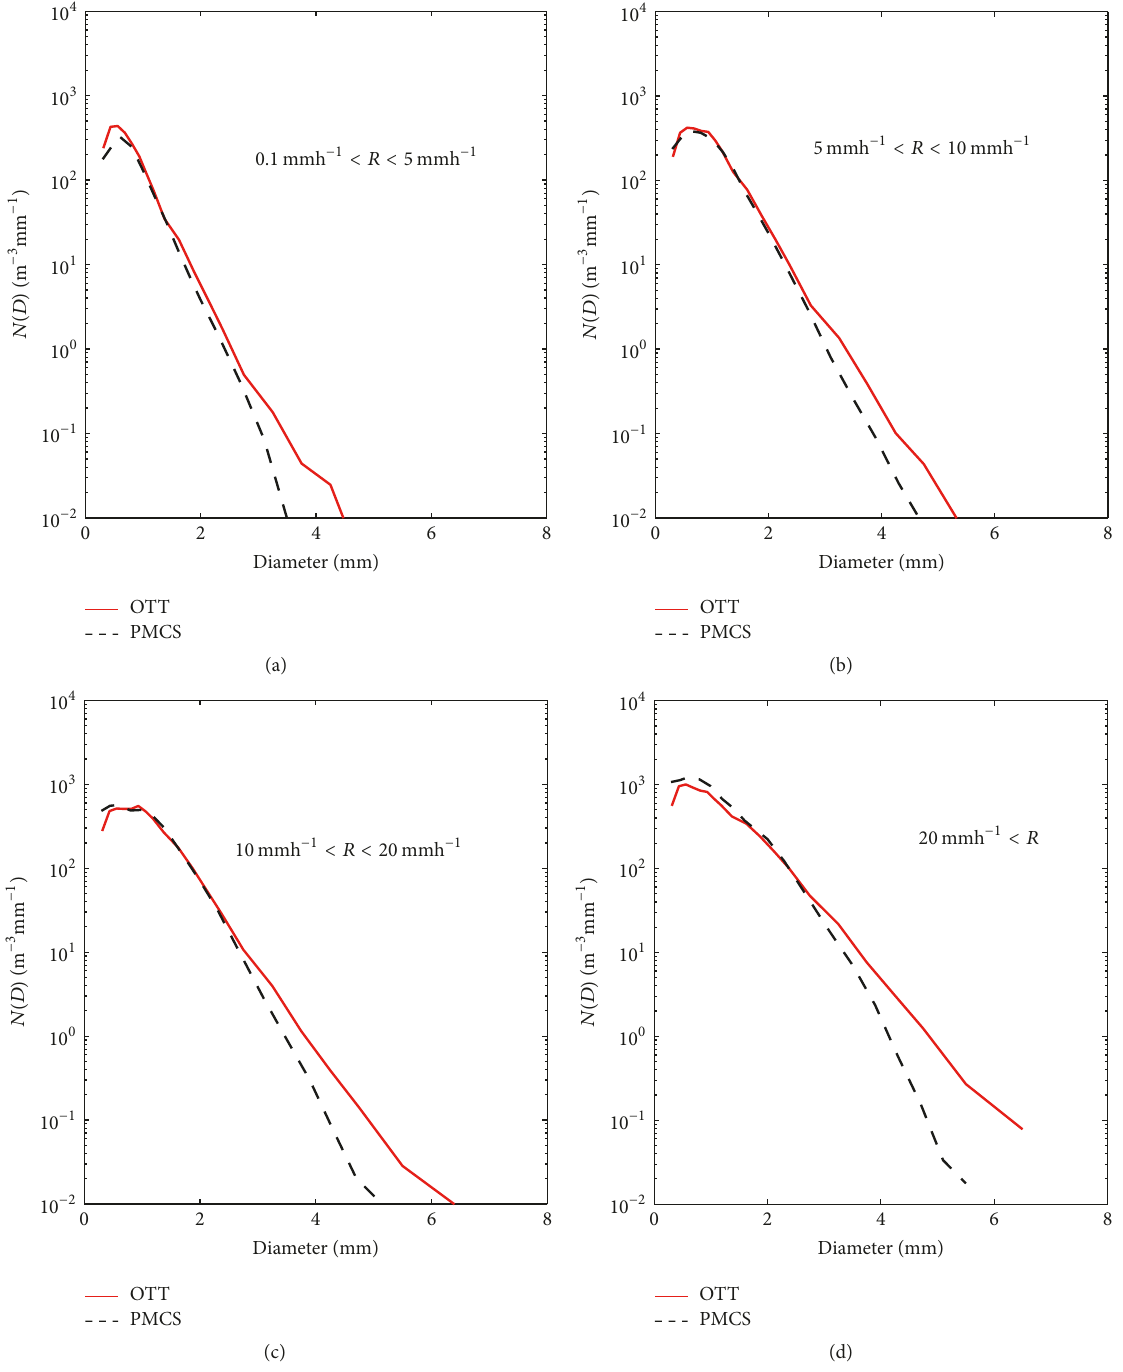
Figure 20: Comparison of the drop size distributions obtained by PMCS (black dashed line) and OTT (red solid line): (a) 0.1 mmh −1 < 𝑅 < 5 mmh −1 , (b) 5 mmh −1 ≤ 𝑅 < 10 mmh −1 , (c) 10 mmh −1 ≤ 𝑅 < 20 mmh −1 , and (d) 20 mmh −1 ≤ 𝑅